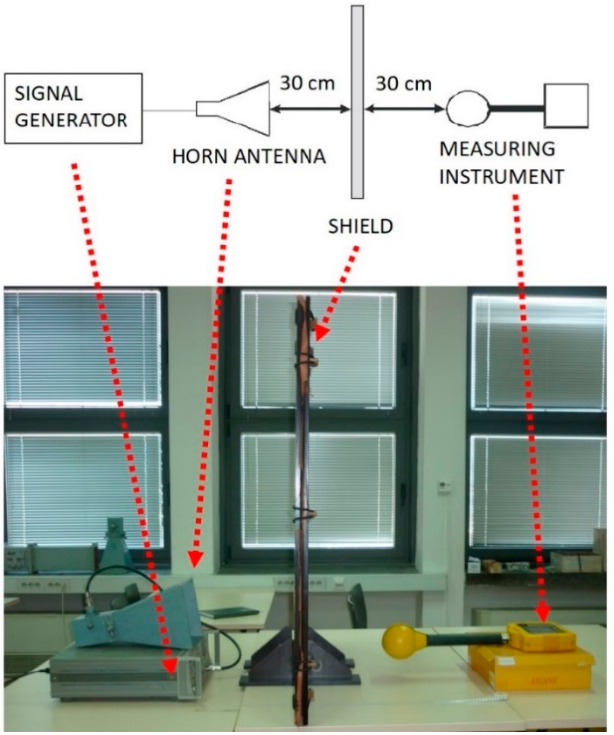
Figure 1. Measurement set up [25].